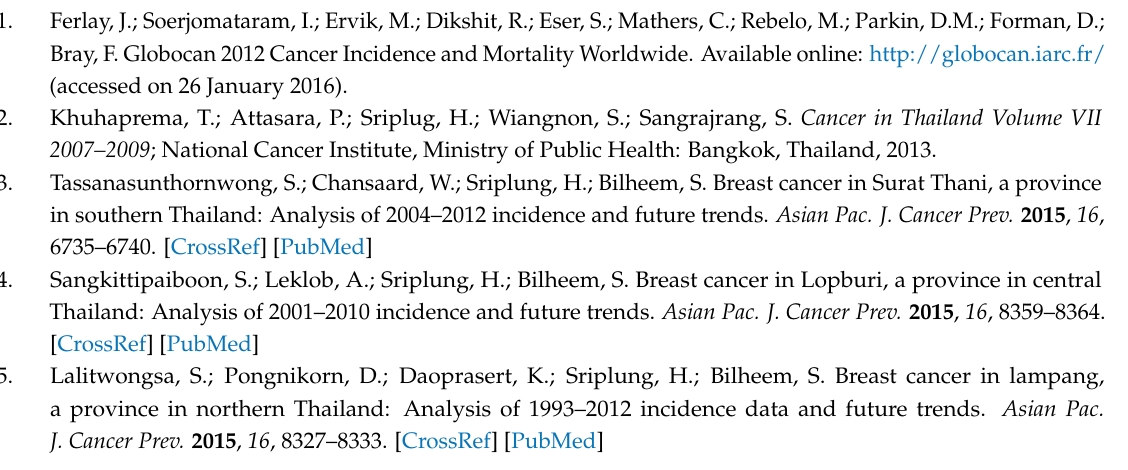
Figure S1: Age-specific incidence rates for each cancer in females only by region. The 80+ age category was removed. Note the Y -axis are different for each cancer, Figure S2: Age-specific incidence rates for each cancer in males only by region. The 80+ age category was removed. Note the Y -axis are different for each